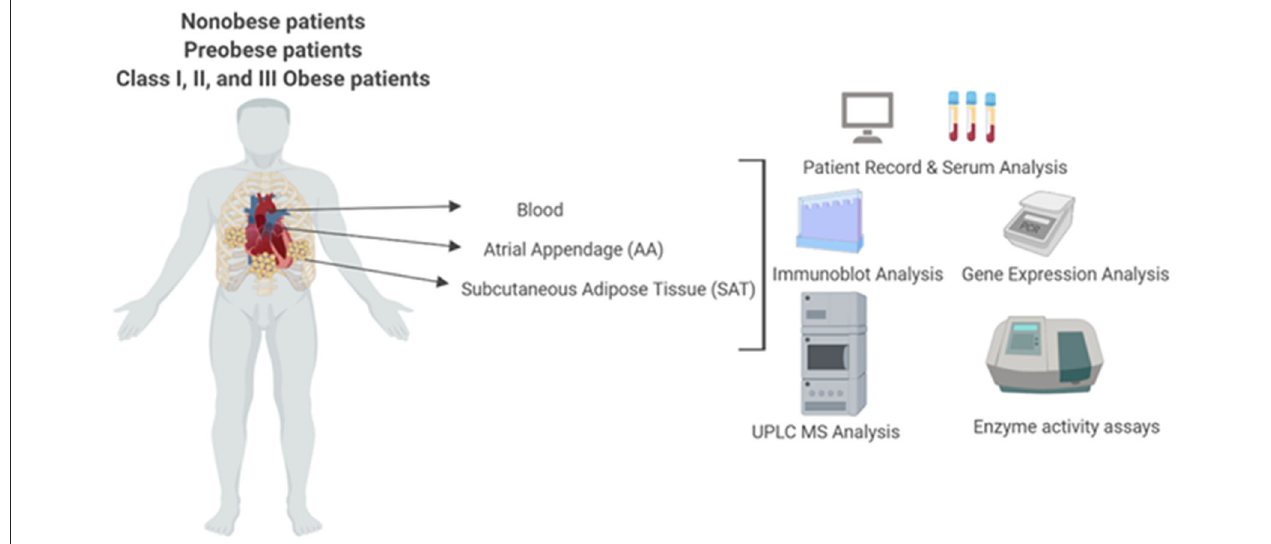
FIGURE 1 | Experimental layout of UPLC-MS analysis of systemic and intracellular BCAA and BCKA measurements in the plasma, atrial appendage and subcutaneous adipose, tissue, BCAA catabolic enzyme mRNA and protein quantification and BCKDH enzyme activity measurements in heart and subcutaneous adipose tissue from non-obese, pre-obese, and obese patients undergoing cardiac surgery.